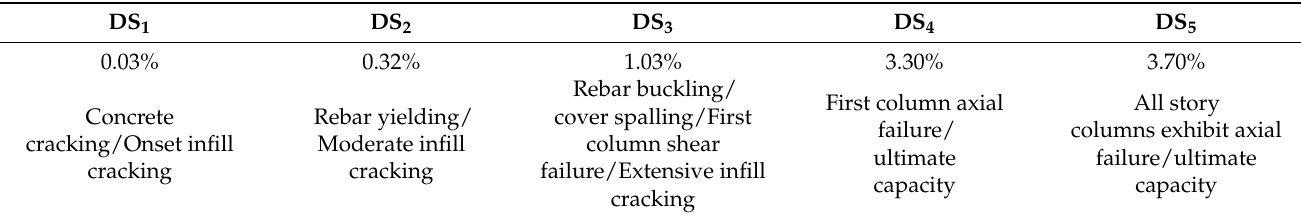
Table 3. Damage state thresholds in terms of interstory drift ratios defined according to EMS-98 scale. DS 1 DS